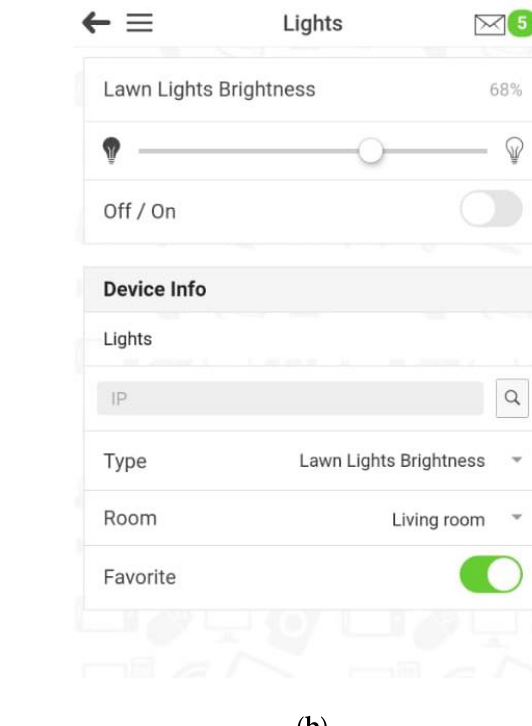
Figure 3. Manual configuration interfaces of the application: ( a ) room settings and its devices; and ( b ) device details and settings.